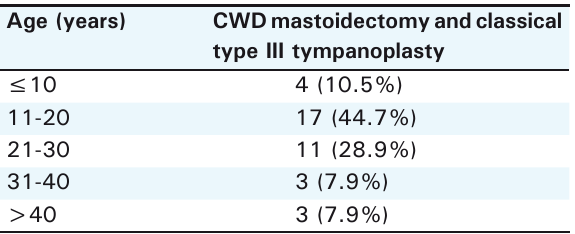
table 3. the pre and post-operative PtA-AbG evaluation of patients with CWD mastoidectomy and classical type III tympanoplasty (n=38) Parameter